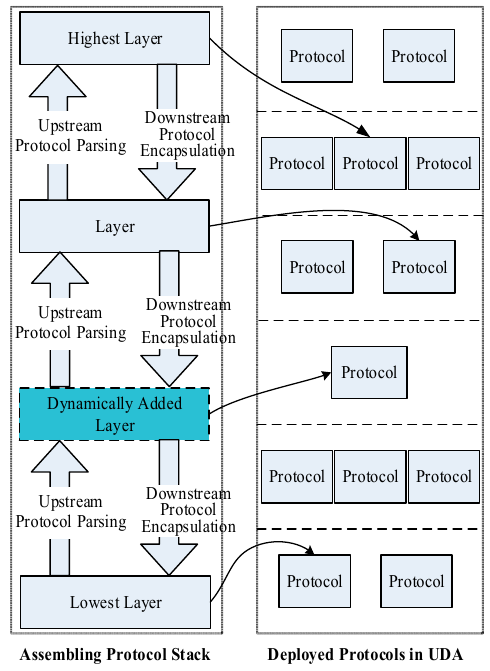
Figure 4. The dynamic assembling of protocol stack.